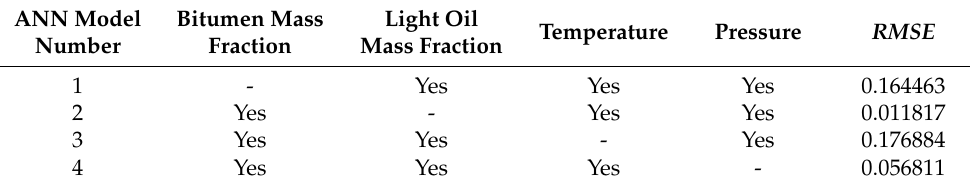
Table 3. Backward stepwise sensitivity analysis of the input parameters.